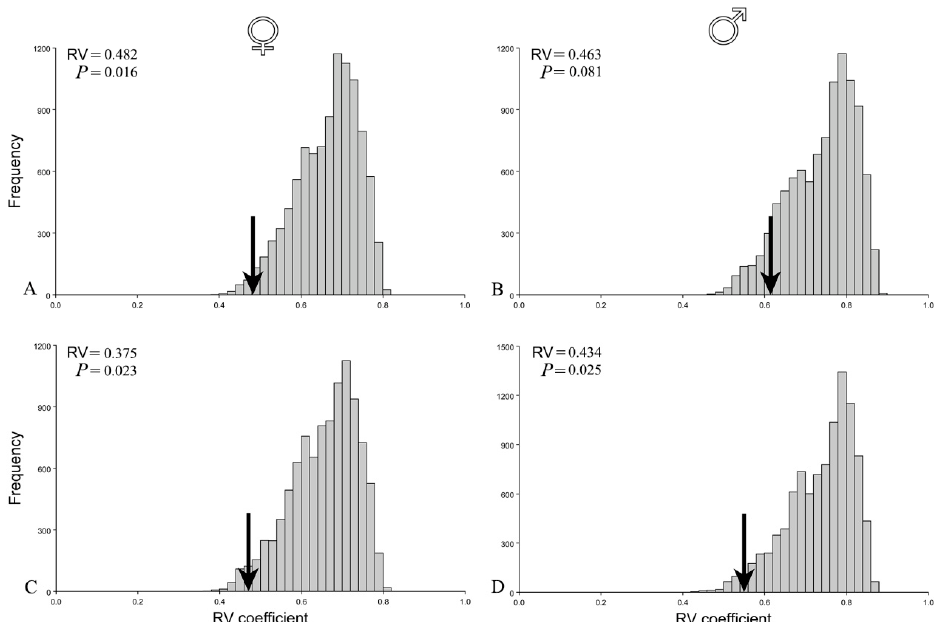
Figure 4. A priori hypothesis of a two-module (thorax—dashed line, abdomensol—id line) organization of female and male seed beetles.